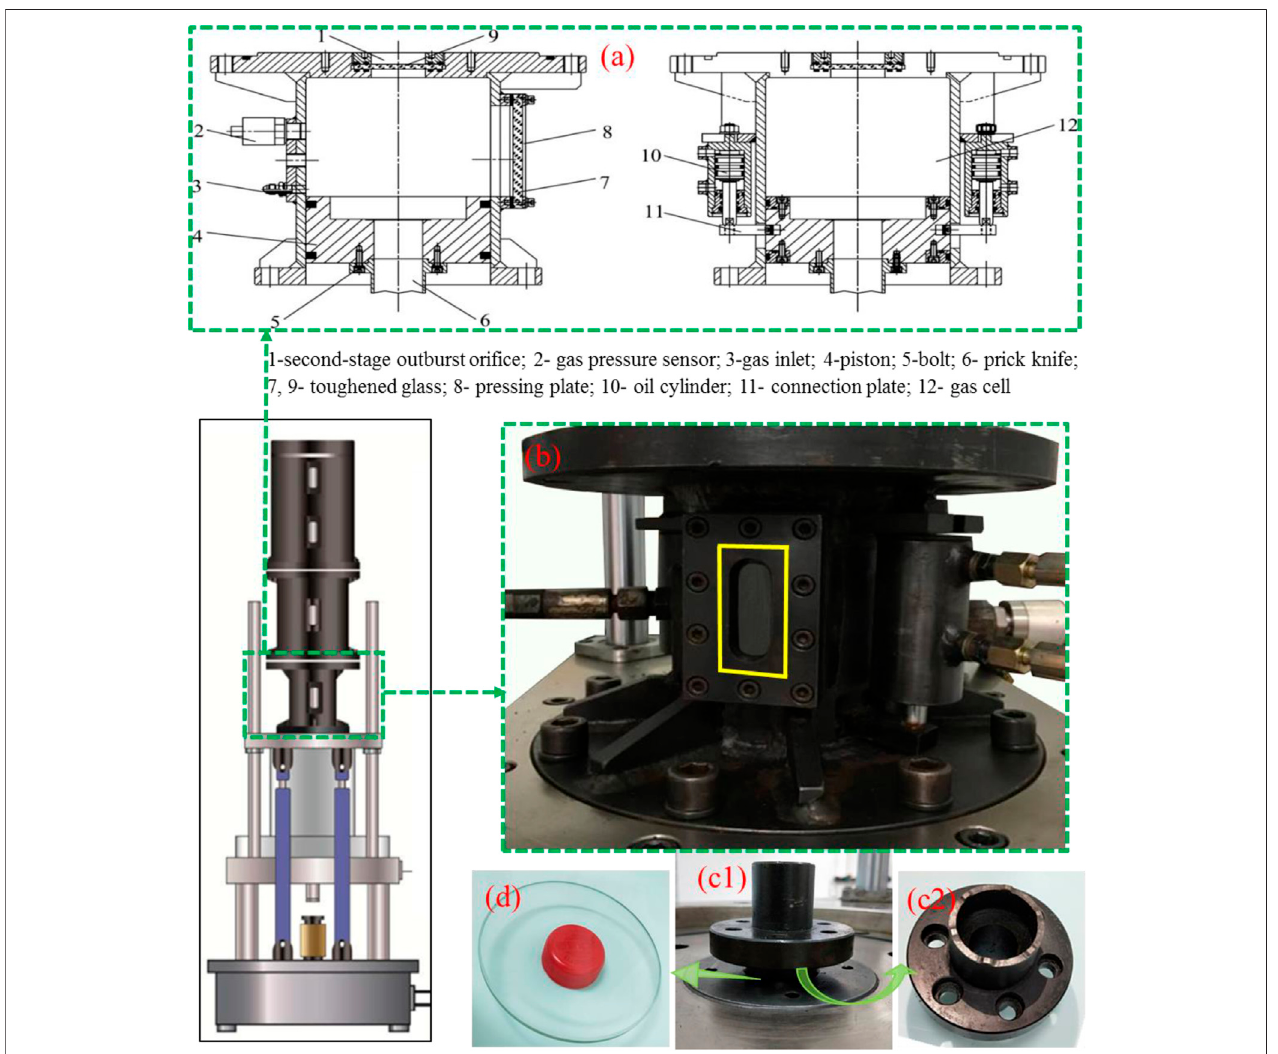
FIGURE 2 | Rapid pressure relief system. Structure diagram (A) and practical picture (B) of the fi rst-stage gas cell; the prick knife (C1) is installed in the outburst ori fi ceofthetriaxialpressurechamberabove thetoughened glass (D) .Thebottom oftheprickknifeisshownin (C2) ,whichwillhitandbreakthetoughenedglassdriven by the pressing plate and the oil